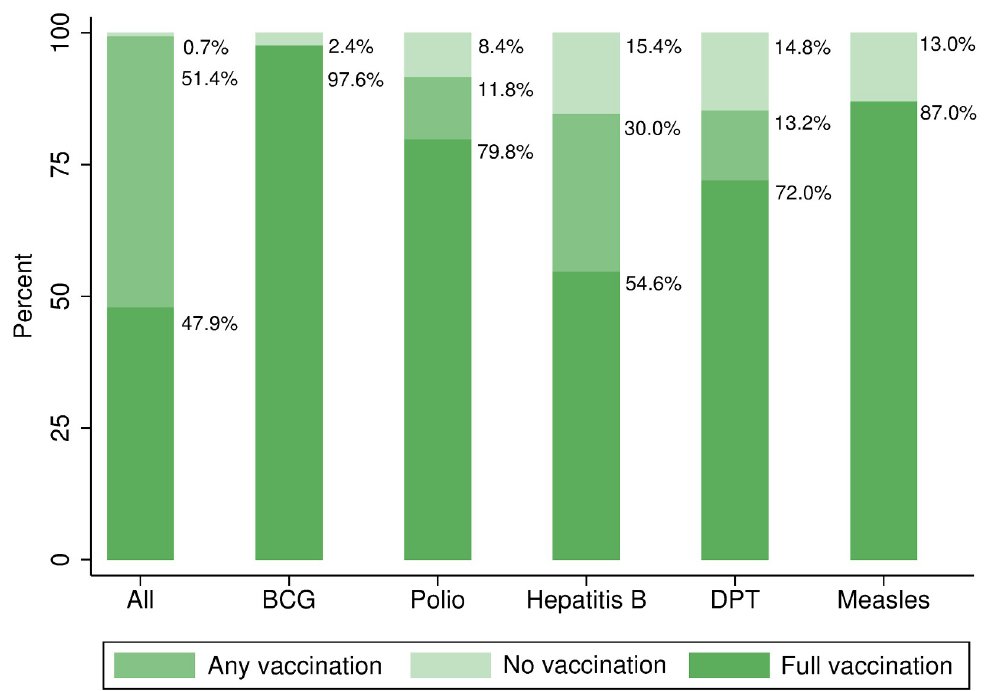
Fig 1. Vaccination status by vaccine. Graph refers to analytical sample; respondents with card verification and complete data. “No vaccination” is equivalent to missing vaccination for the respective vaccine. “All” presents a summary over all vaccinations recommended until the age of twelve months by the WHO and the national vaccination schedule of India; one dose of BCG vaccine, three doses of polio vaccine, three doses of hepatitis B vaccine and three doses of DPT vaccine and one dose of measles vaccine. Pentavalent vaccine doses account for the equivalent number of hepatitis B and DPT vaccination doses.